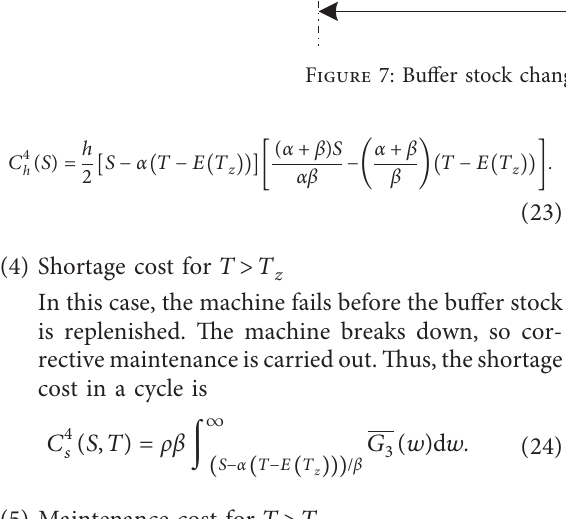
Figure 7: Buffer stock change diagram in a cycle for T > T